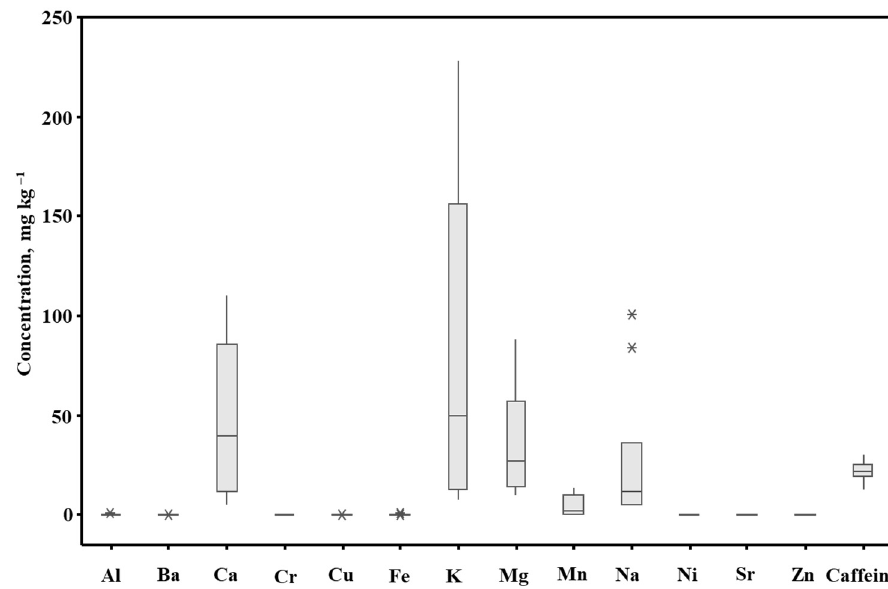
Figure 1. Box-and-whisker plots of the results of the analysis of the yerba mate (YM) drinks. *—an unusually large or small observation.